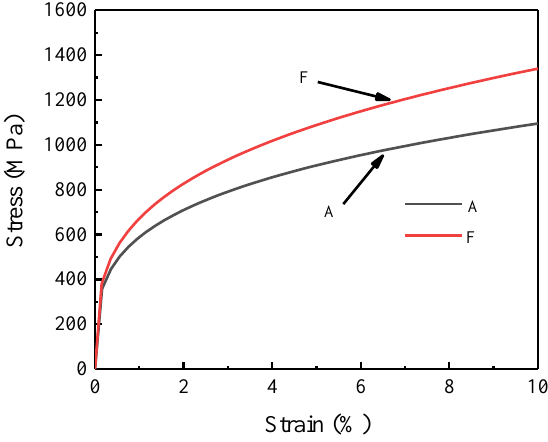
Figure 9. Tensile curves of austenite and ferrite phases.